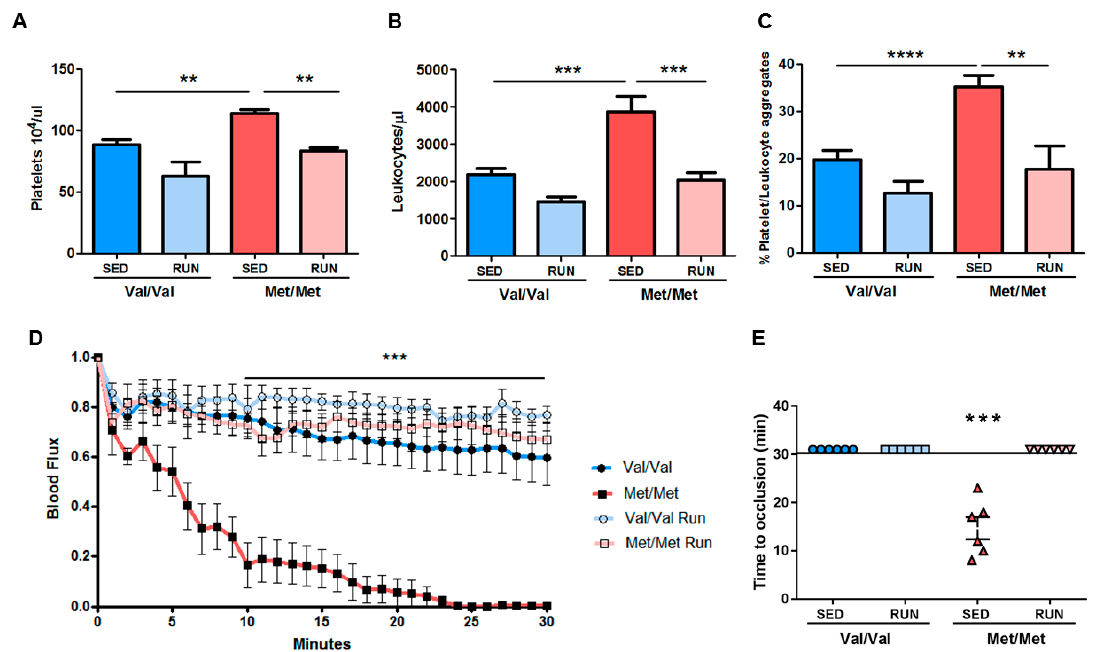
Figure 6. Effect of voluntary physical exercise (PE) on the prothrombotic phenotype of BDNF Val/Val and BDNF Met/Met mice. Numbers of circulating ( A ) platelets and ( B ) leukocytes. ( C ) Percentage of platelet/leukocytes in whole blood analyzed by flow cytometry. Arterial thrombosis induced by topical application of FeCl 3 to the carotid artery: ( D ) blood flow and ( E ) time to occlusion measured in sedentary and running BDNF Val/Val and BDNF Met/Met mice. n = 6 mice/group. ( A – C and E ) Two-way